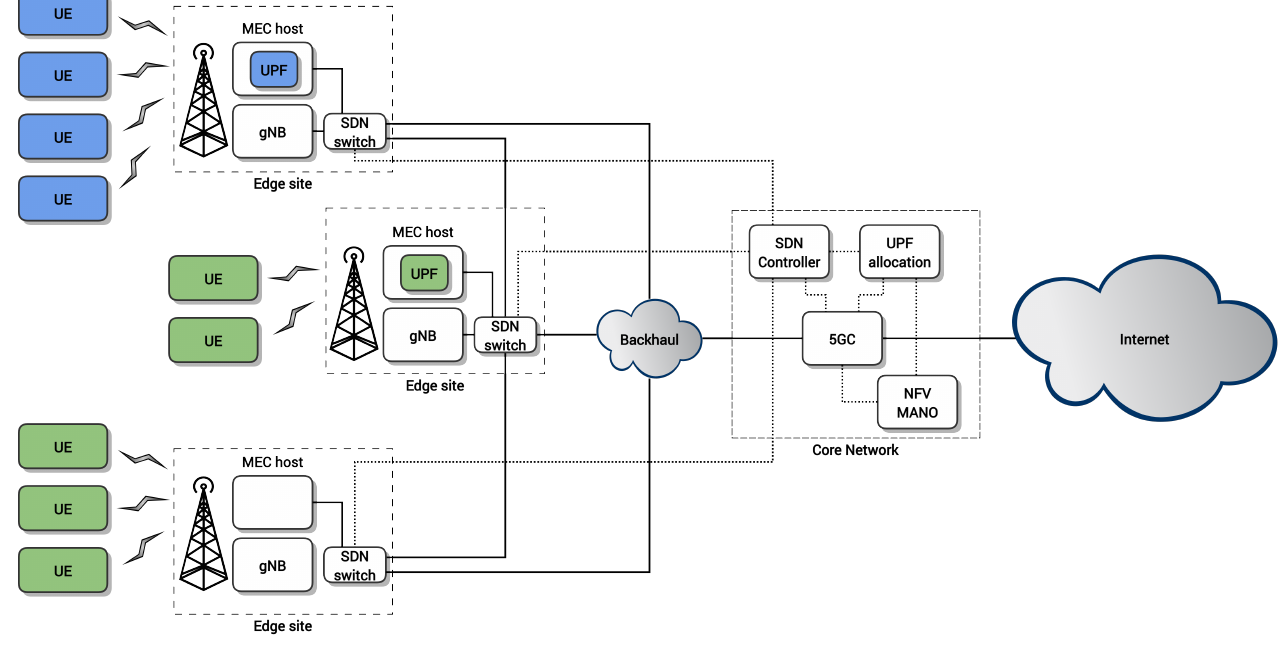
Figure 1. Architecture of the proposed